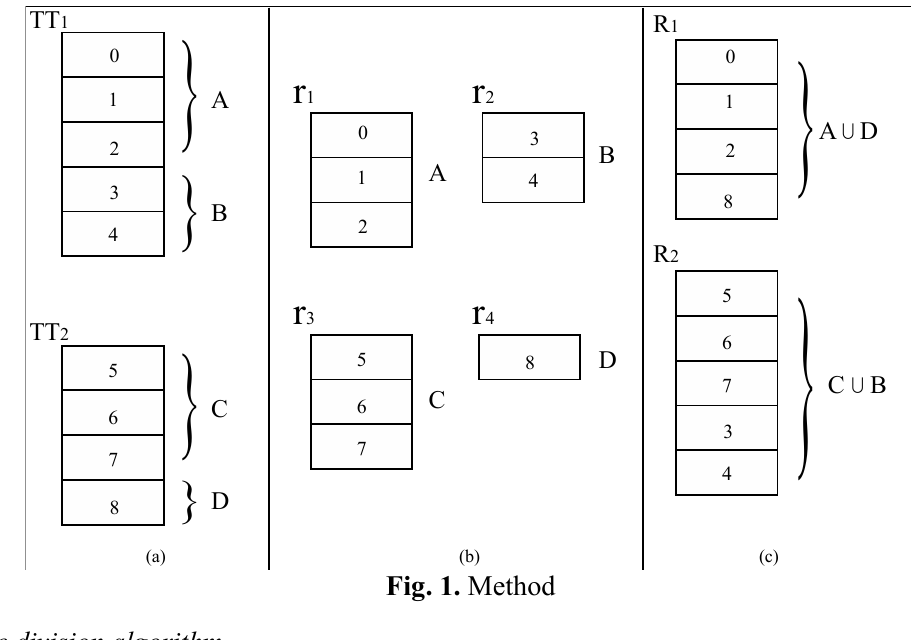
Fig. 1. The first trip of the work shift generated by the division must start at the depot (node 0 ). Fig. 2. The last trip of the work shift generated by the division must end at a hub or the depot (node (cid:1866) (cid:3397) 1 ). of all trips included in a division (cid:1870) must be less than or equal to the Fig. 3. The sum of the times (cid:1875) (cid:3036) maximum time (cid:1846) a driver may work continuously, as expressed in Eq. (cid:3020)